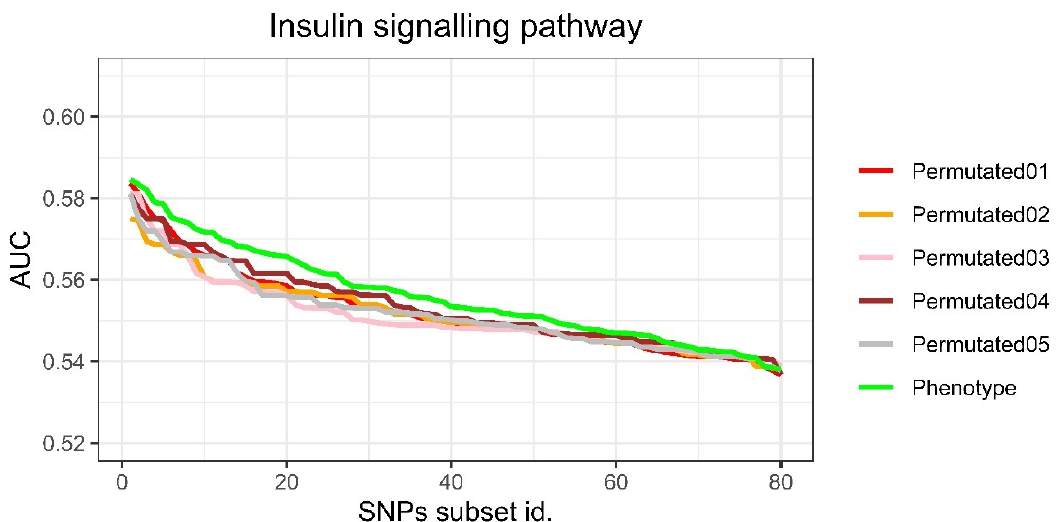
Figure 12. AUC values of the 80 iterations performed for the insulin signaling pathway in the case of cases and controls (phenotype) and five different permutations.